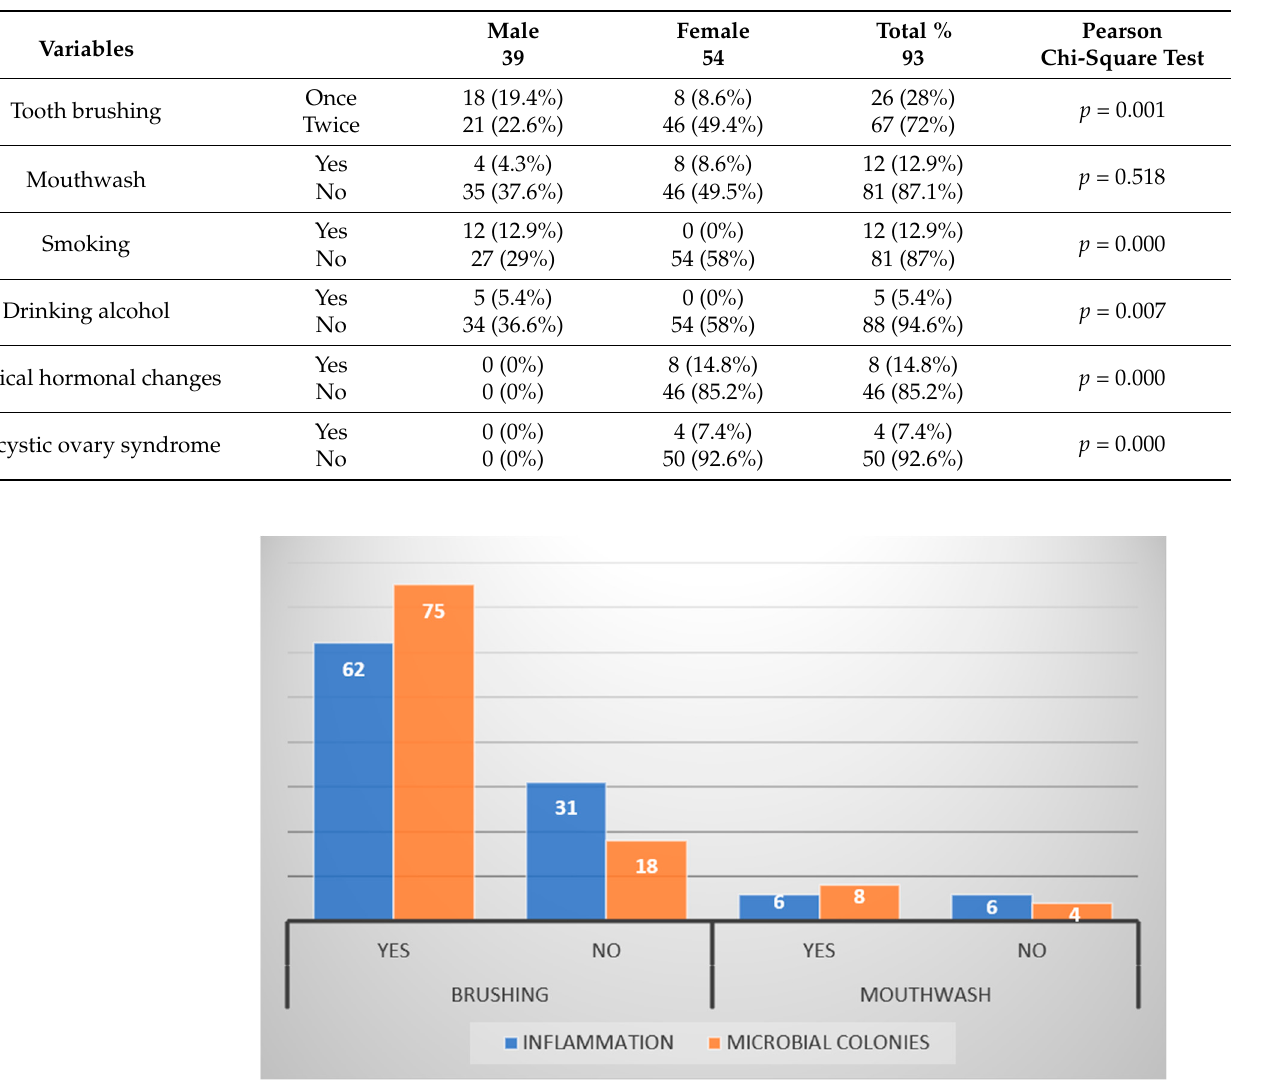
Table 1. Sex distribution concerning oral health maintenance, habits, and hormonal disturbances.